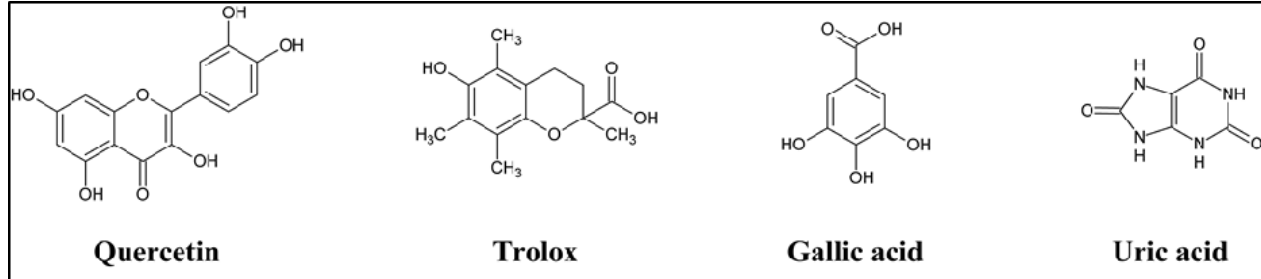
Figure 2. Chemical structure of standard compounds used as positive controls for antioxidant